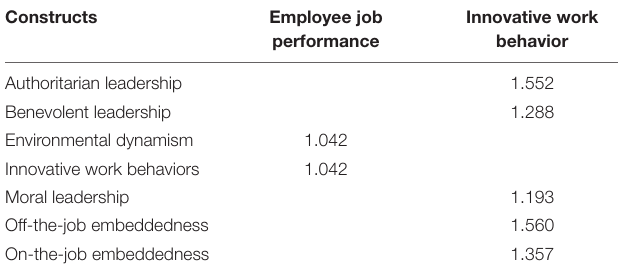
TABLE 4 | Assessing multicollinearity using variance inflation factor (VIF) statistics.